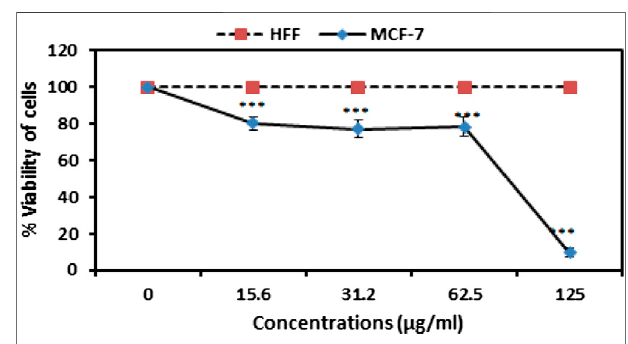
FIGURE 4 | Analysis of MCF-7 and HFF cell viability in treatment with various concentrations of SEO-SCF-NPs. The results were represented as mean ± SD and “ *** ” p < 0.001.